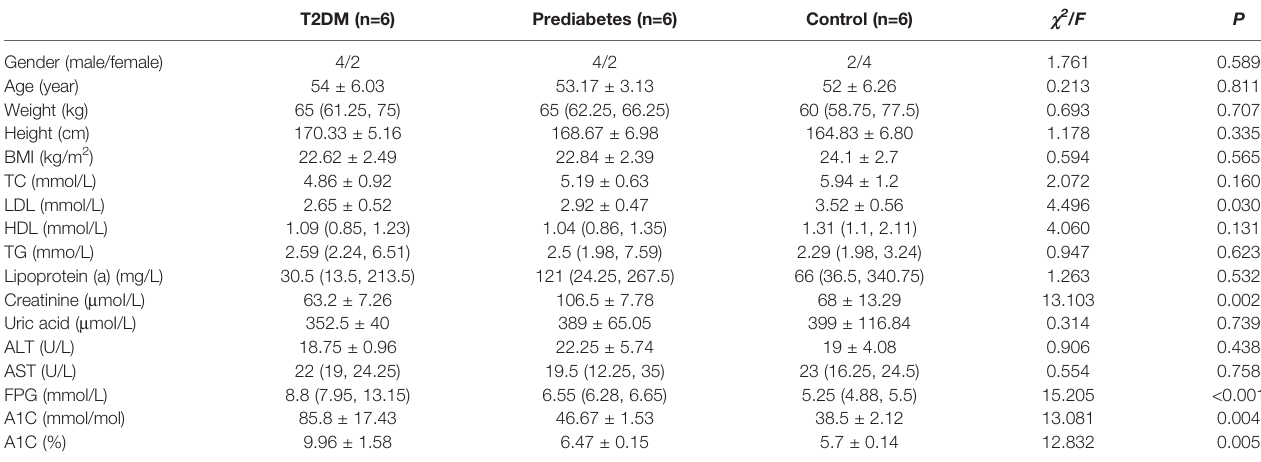
TABLE 1 | Basic Situation of Participants in the